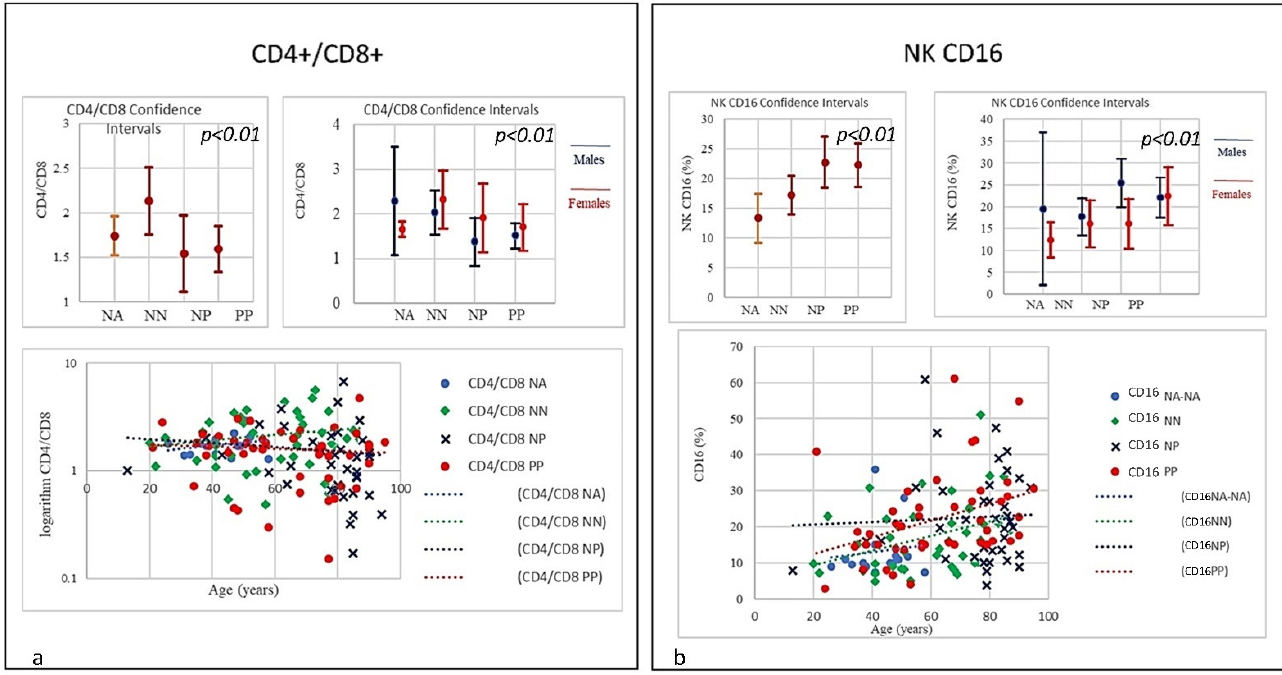
Figure 4. ( a ) Frequencies of CD4/CD8 ratio in COVID-19 patients and controls (NP, NN, and NA). The PP and NP groups showed a similar low trend (<1) compared to the control groups NN and NA ( p < 0.001). A low or inverted CD4/CD8 ratio is associated with abnormal immune activity, immune senescence, and chronic inflammation, conditions typical of HIV populations. The prevalence of an inverted CD4/CD8 ratio increased with age. ( b ) Frequencies of NK CD16 lineage in COVID-19 patients and controls (NP, NN, and NA). A strong correlation was observed between age and the NK increase in the PP group: the older the higher; the NP group showed a lesser increase, though the starting NK levels were significantly higher than PP individuals ( p < 0.01) .